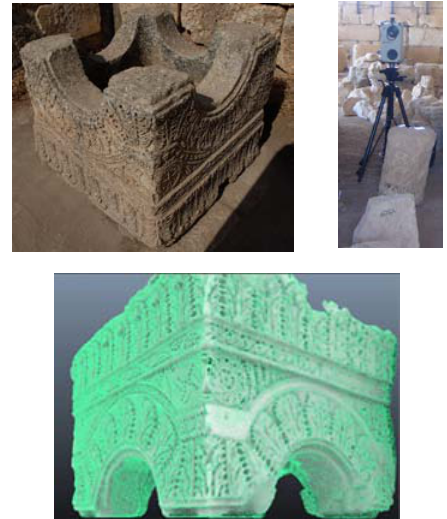
Figure 12. Anastylosis of tow cases: the baptistery basin and its canopy (up) and the oculus of the western basilica (down).